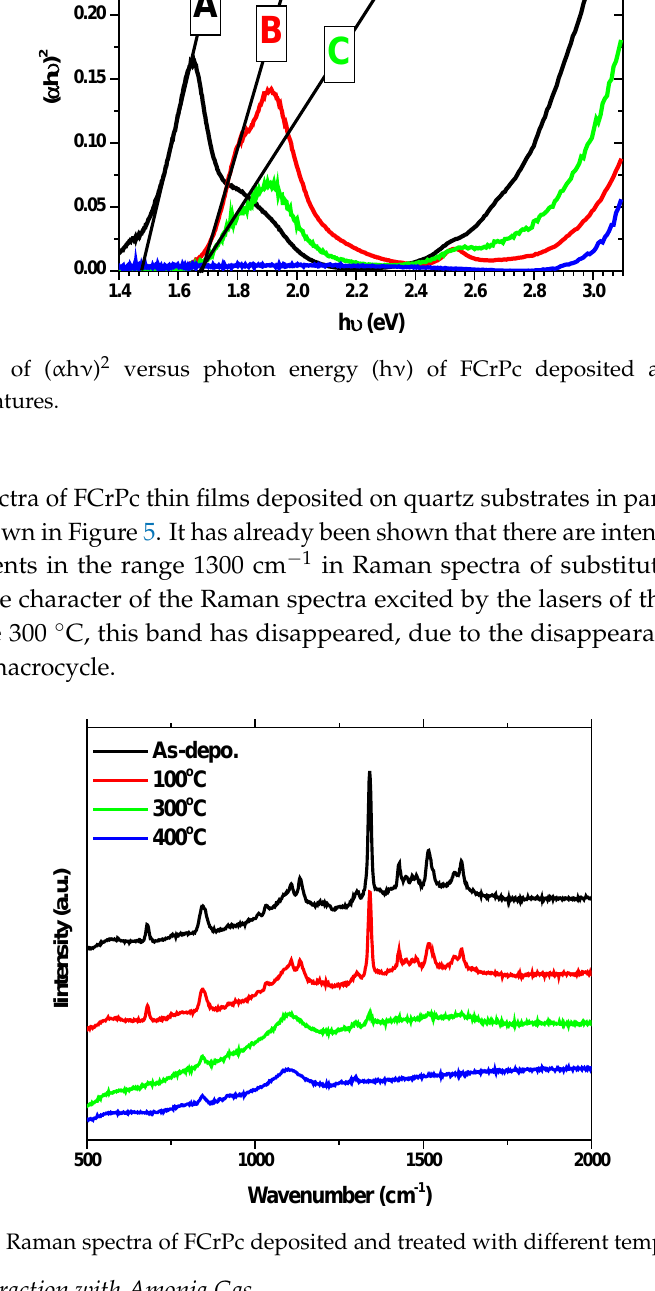
Figure 5. Raman spectra of FCrPc deposited and treated with different temperatures.